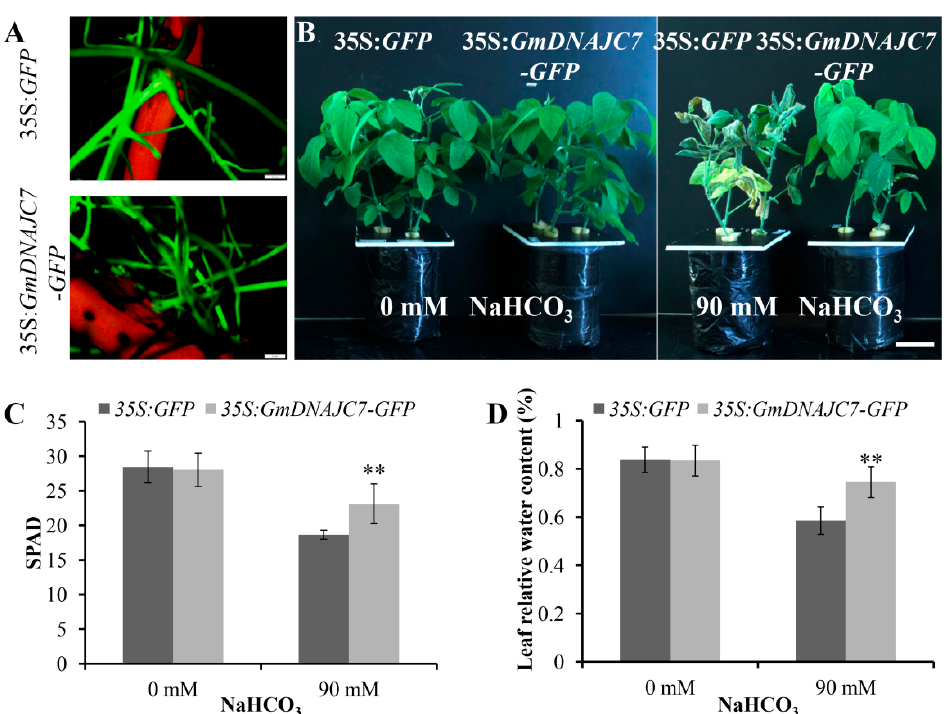
Figure 5. Alkaline-salt tolerance analyses of transgenic soybean composite plants. ( A ) Identification of positive transgenic soybean plants by green fluorescence using a stereoscopic fluorescence microscope. Bar = 1 cm. ( B ) Phenotype of transgenic soybean composite plants under 0 mM or 90 mM NaHCO 3 for five days. Bar = 5 cm. ( C , D ) The SPAD (Soil and Plant Analysis Development) value for the chlorophyll content and leaf relative water content (LRWC) of transgenic soybean composite plants under 0 mM or 90 mM NaHCO 3 for five days, respectively. Data represent the mean ± standard deviation of three biological replications and each repeat contained four independent transgenic plants ( n = 3 × 4 = 12). The soybean variety of “TianLong1” was used. Differences were evaluated using the two-tailed Student’s t tests (** p < 0.01).